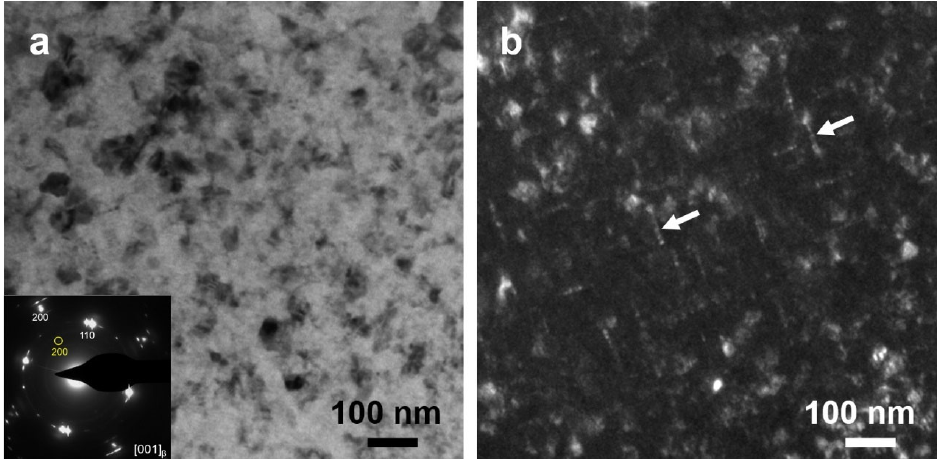
Figure 4. ( a ) Bright field TEM image in the diffusion zone. The inset shows SAED pattern from the [001] β zone axis. The indexing for the matrix and superlattice spots are marked in white and yellow, respectively. ( b ) Dark-field TEM image obtained by electrons scattered by orientation from the yellow circle in ( a ). The superlattice spots correspond to the diffraction of rod ‐ like D0 3 –Mg 3 Al precipi ‐ tates (white arrows).